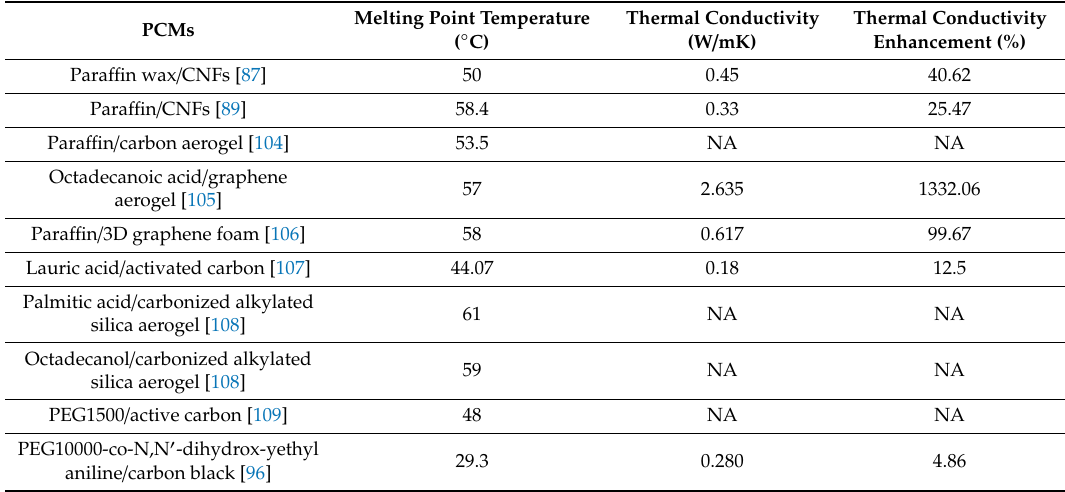
Table 5. Thermal properties of organic PCMs filled with other carbon